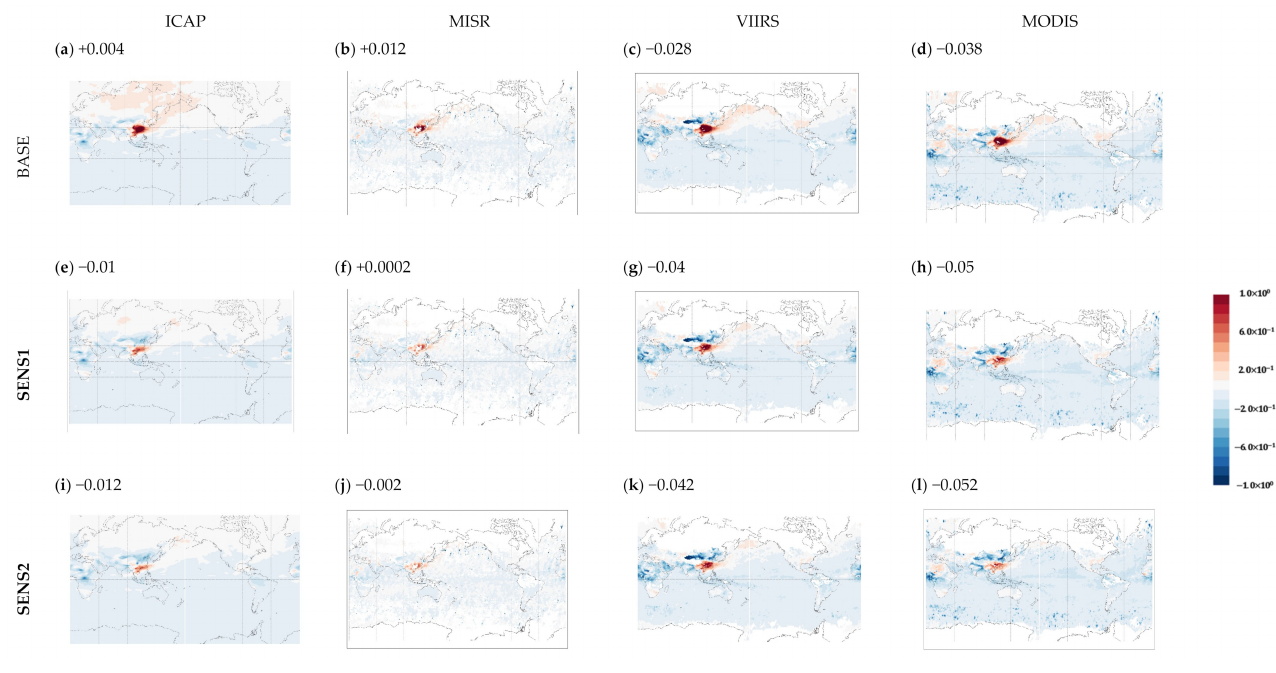
Figure A2. Global distribution of the differences in GEFS AOD ( BASE ( a – d ), SENS1 ( e – h ) and SENS2 ( i–l )) from ensemble simulation of ICAP ( a , e , i ), and satellite observations of MISR ( b , f , j ), VIIRS ( c , g , k ), and MODIS ( d,h,l ) in SON 2021 (the numbers above figures indicate global mean (unitless)).